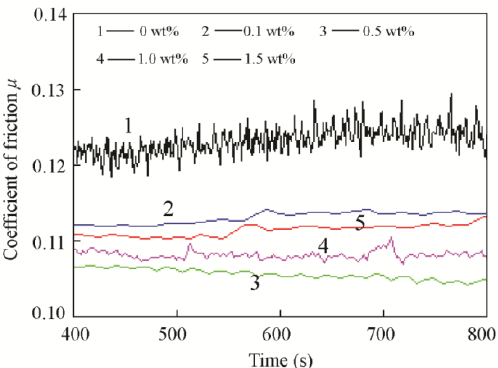
Figure 2. Scanning electron microscopy (SEM) image of lamellar MoO 3.